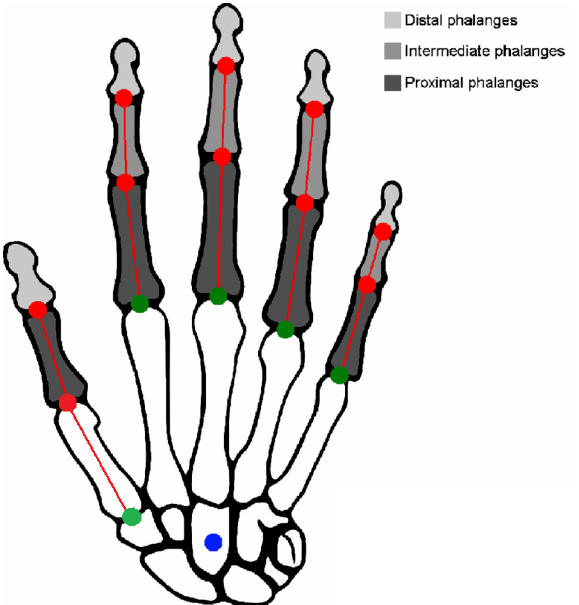
Figure 1. Proposed hand model (adapted from